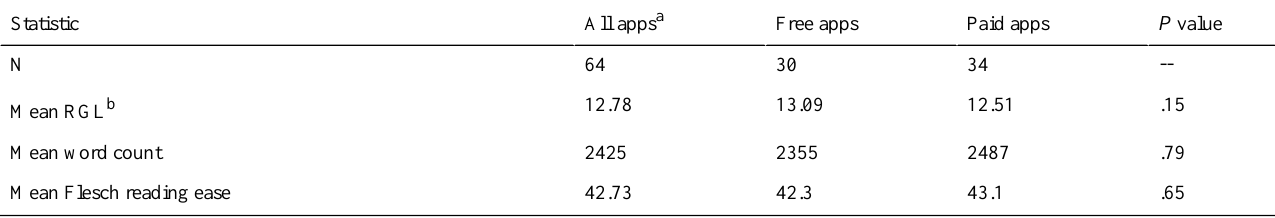
Table 2. Mean readability statistics. Free versus paid: comparison of mean reading grade level (RGL), mean word count, and mean reading ease between free and paid apps from both the Android and Apple markets. The P values for the t tests between the two app types show that there is no significant difference between mean RGL, word count, and reading ease.